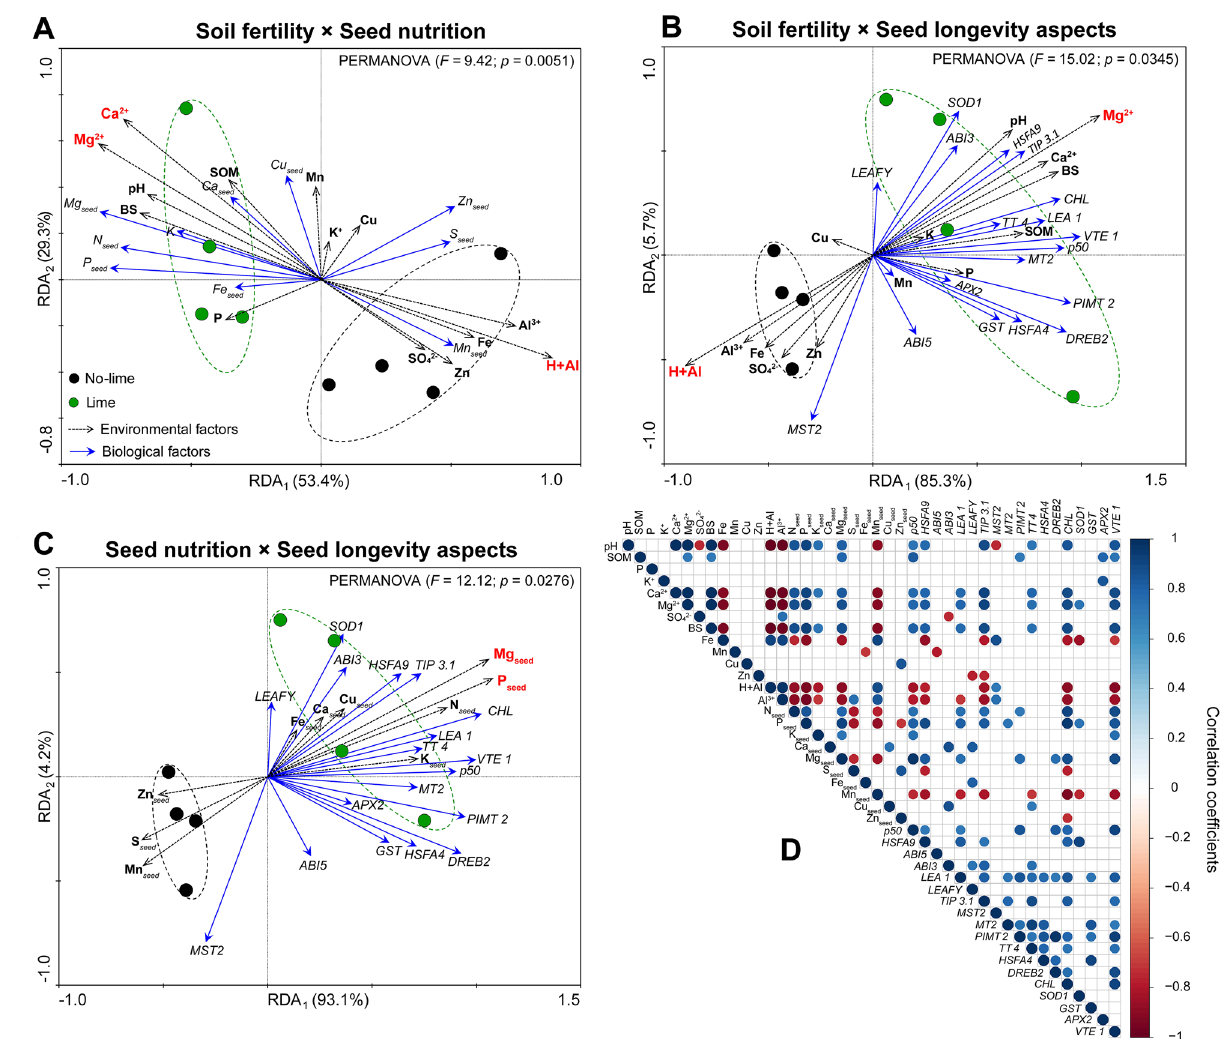
Figure 3. Triplot redundancy analysis (RDA) of the nutrient concentration, longevity gene expression and p 50 of wheat seeds. Arrows indicate correlations between factors. The significances were evaluated by a Monte Carlo permutation test (999 permutations) and are indicated by the red color ( P ≤ 0.05). The dashed lines indicate significant clusters according to the permutation analysis (PERMANOVA, P ≤ 0.05). Heatmap correlation (Pearson) based on the same factors used in the RDA. Only significant correlations ( P ≤ 0.05) are